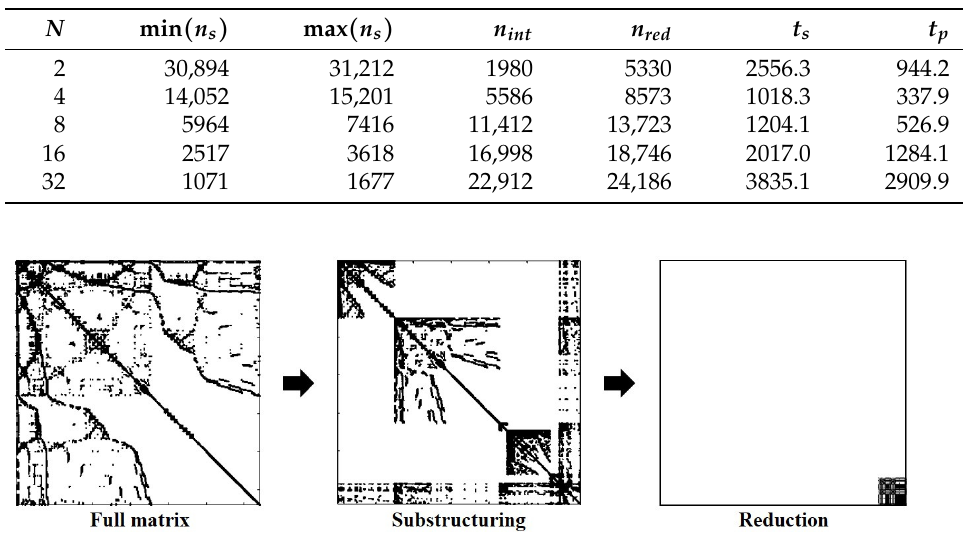
Table 6. Reduction time [minute], Shaft Assembly.